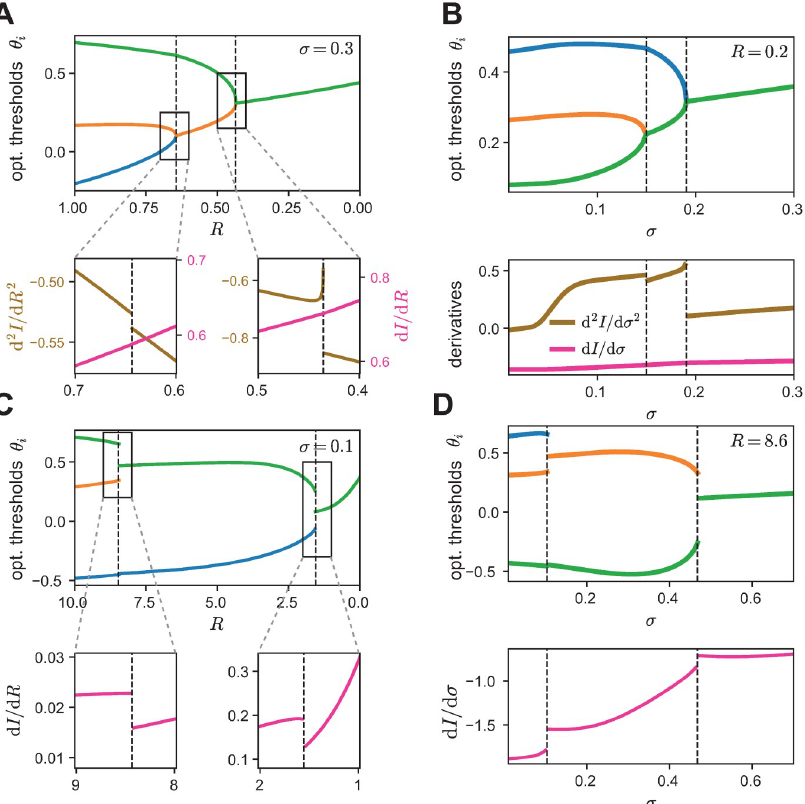
Fig 5. Threshold differences as phase transitions with respect to both noise sources. A . Optimal thresholds for the independent-coding channel depending on output noise R . Insets: The first derivative of the mutual information as a function of noise is continuous, while the second derivative is discontinuous at the critical noise values where the thresholds separate, implying a second-order phase transition. B . As in A, but with respect to input noise σ . C . Optimal thresholds as in A but for the lumped-coding channel. The first derivative is discontinuous at the critical noise values where the thresholds separate, implying a first-order phase transition. D . As in C but with respect to input noise σ